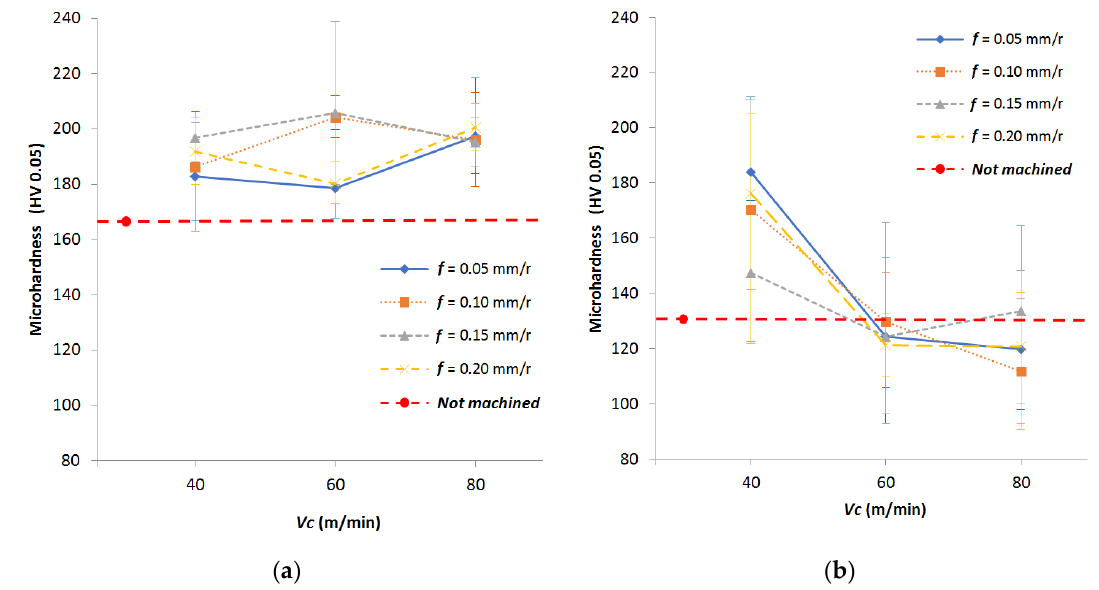
Figure 7. Surface microhardness ( a ) before corrosion and ( b ) after corrosion.